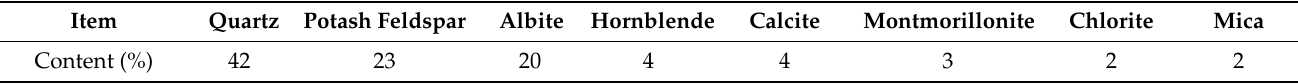
Figure 2. XRD-ray diffraction pattern.